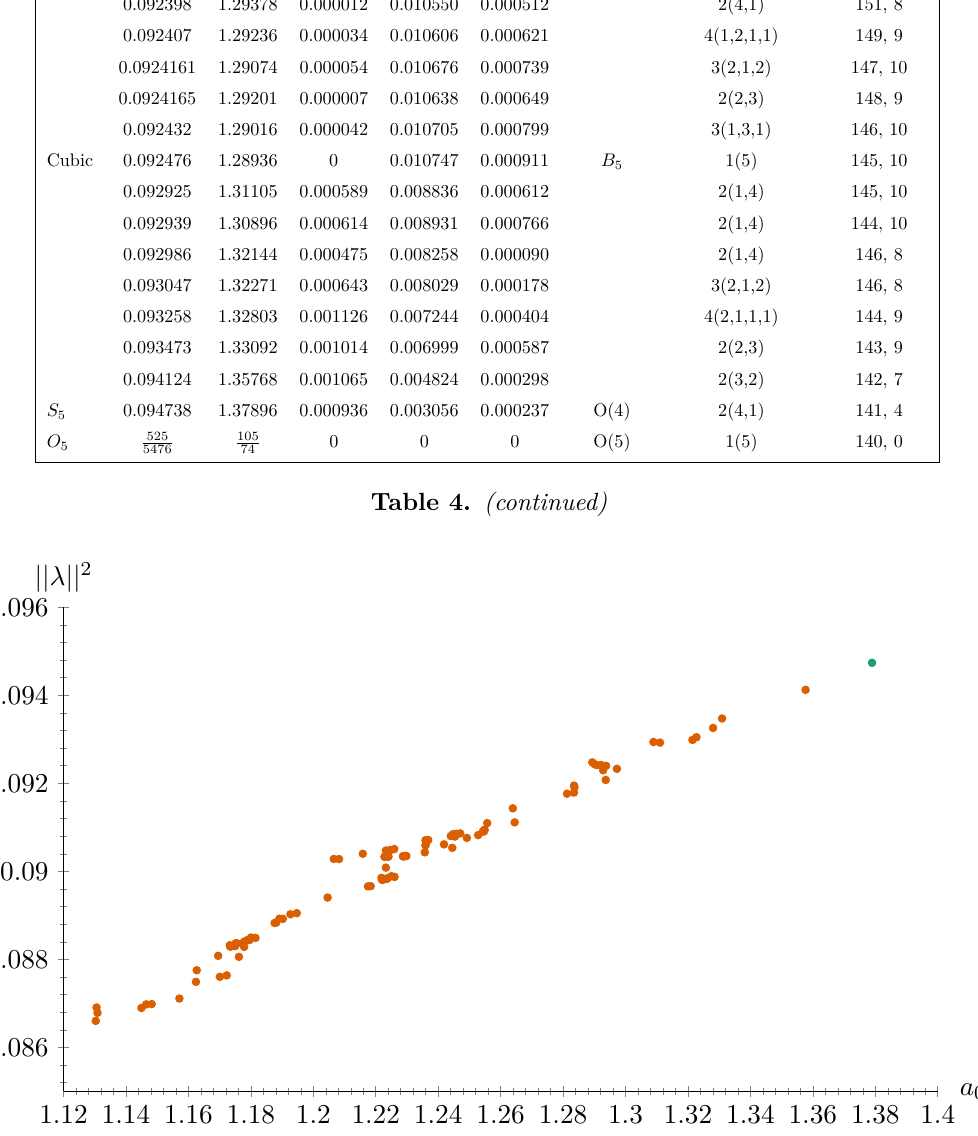
figure 6. The distribution of fixed points in d = 3 − ε is similar to that of figure 1 of the d = 4 − ε